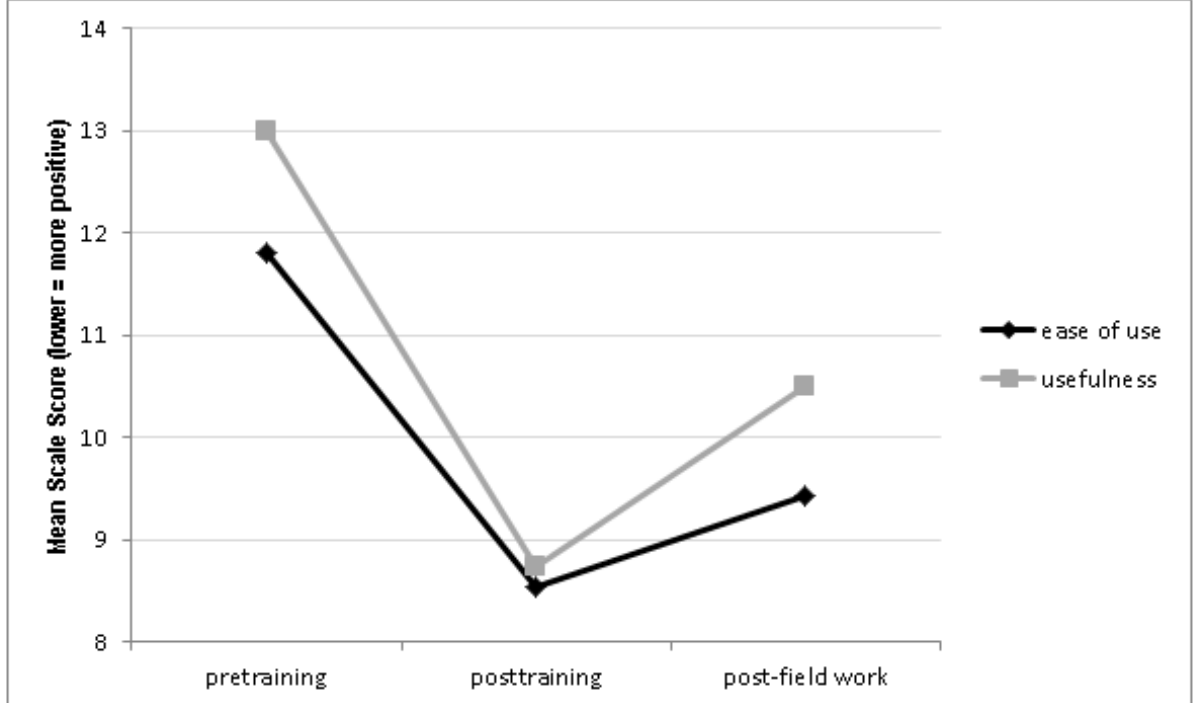
Figure 7. Estimated marginal means for the main effect of